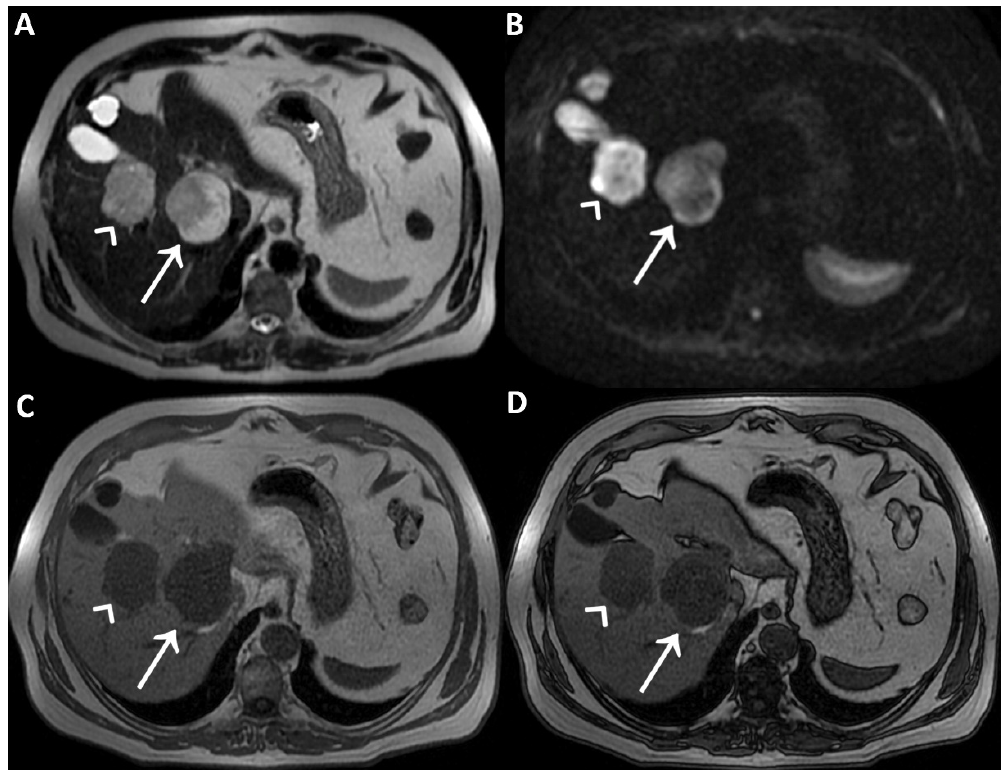
Figure 1. A man in his early 60s with unremarkable medical history and normal laboratory data underwent an abdominal ultrasound for insurance reasons, which detected two liver lesions, the largest one localized deeply in the hepatic parenchyma. Due to the patient’s high body mass index, which reduced the ultrasound’s diagnostic quality, panoramic imaging was required to achieve the final diagnosis. Therefore, the patient underwent liver Magnetic Resonance Imaging (MRI) performed with hepatospecific contrast agent (Gd-EOB-DTPA). MRI was performed by using a 1.5 T superconducting system (Signa; GE Medical Systems, Milwaukee, Brookfield, WI, USA) with a body phased-array multicoil for signal detection. The two liver lesions appeared to be inhomogeneously hyperintense on T2-Weighted Images (T2WI) (straight arrow and arrowhead in ( A )) and on Diffusion-Weighted Images with b-value = 800 (DWI) (straight arrow and arrowhead in ( B )) and homogeneously hypointense on T1-Weighted Images (T1WI) (straight arrow and arrowhead in ( C ), in-phase T1WI, and ( D ) opposed-phase T1WI). It was not possible to establish the benignity of the two liver lesions evaluating T2WI and DWI acquired after contrast agent administration, in particular due to the inhomogeneous signal intensity shown on T2WI. To ascertain that it had not been caused by the contrast-induced reduction in the hydrogen nuclei relaxation time, it was necessary to re-acquire the same images without previous contrast administration a few days later.